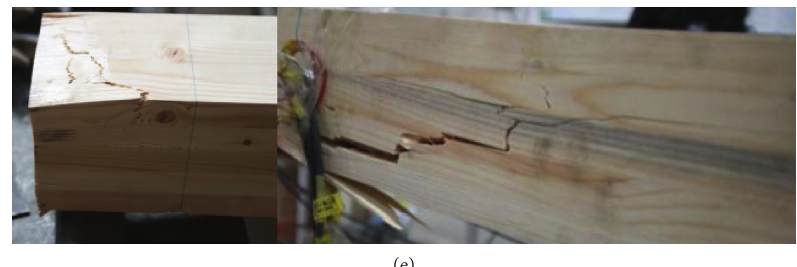
Figure 5: Failure modes of test beams. (a) Tension failure of the bottom laminate of SPF-1.1. (b) Tension failure of the beam bottom of SPF- 1.2. (c) Compression failure of the beam top of SPF-1.3. (d) Tension failure of the bottom of SPF-2.2. (e) Tension failure caused by the crack of the end of